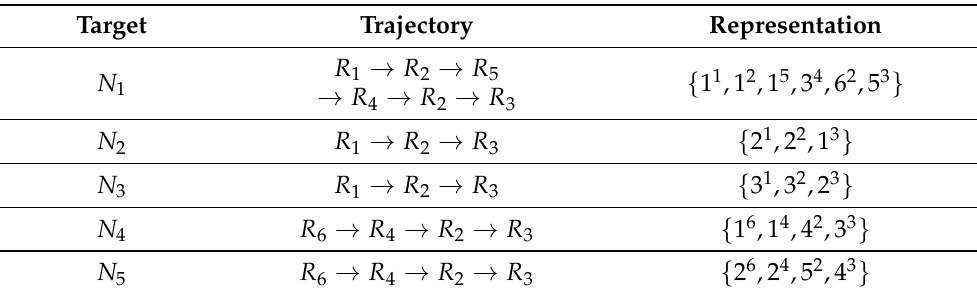
Table 4. Ground truth for five targets trajectories. The representation of A i denotes the associated data group A in road segment R i